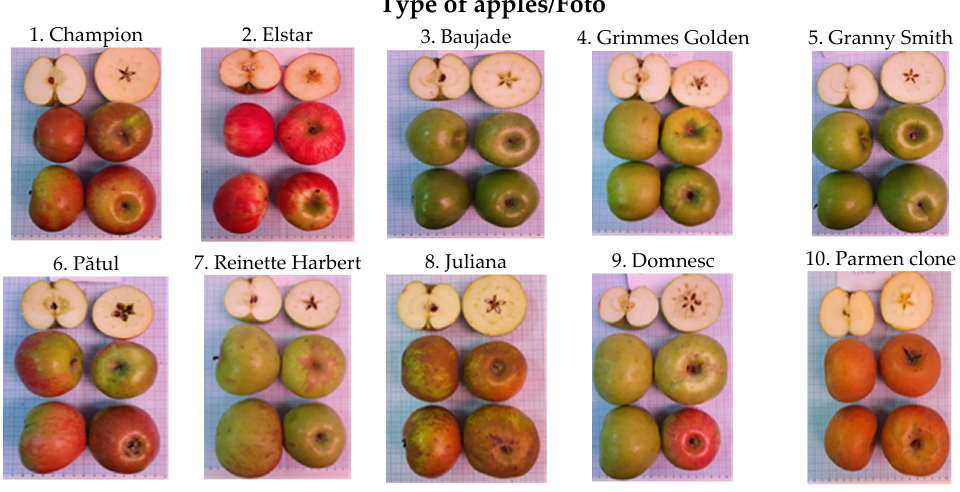
Figure 1. Varieties of apples studied.